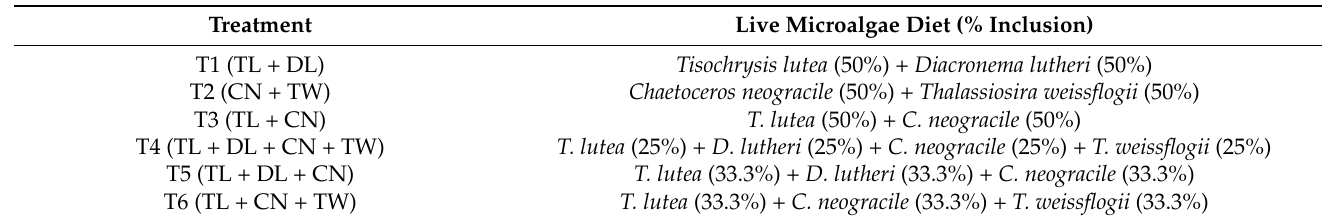
Table 1. Microalgae dietary treatments fed to post-set sunray venus clams ( Macrocallista nimbosa ). Treatment Live Microalgae Diet (% Inclusion) T1 (TL +